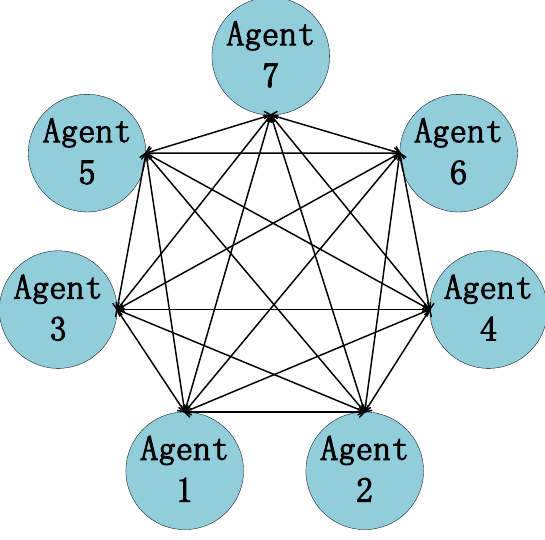
Figure 3. Multi - agent communication topology. Figure 3. Multi-agent communication